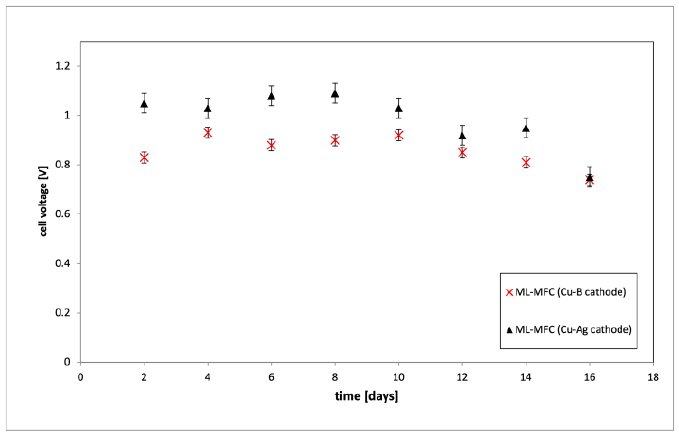
Figure 9. Curves of cell voltage in time (obtained during the ML-MFC operation). Cathode: Cu-Ag (5% of Ag, after 6 h of oxidizing and after 3 times of anodic charge); and Cu-B (9% of B, after 8 h of oxidizing and after 3 times of anodic charge) for comparison [26,63].